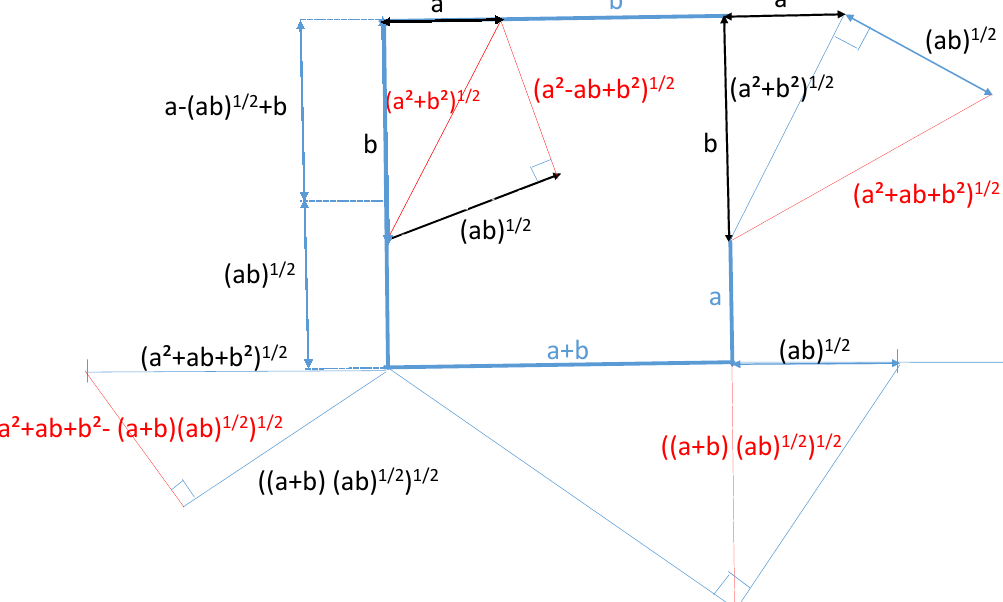
Figure 4. Geometric constructions of Geometric constructions of p a 2 + b 2 , p a 2 (cid:113) a 2 + ab + b 2 − ( a + b ) ( a + b ) p ab . (cid:0)